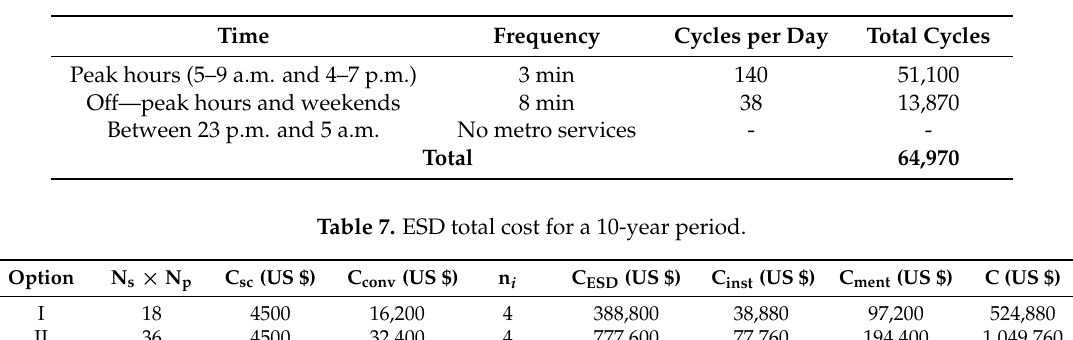
Figure 8. Simulation results for Ea, Ed—energy during acceleration and braking respectively; Sa, Sd—distance travelled during acceleration and braking respectively; ya, yd—route velocity optimization parameters (33): ( a ) velocity limitation parameter for acceleration, ( b ) velocity limitation parameter for braking. Table 6. Assumed train operation for a calendar year.